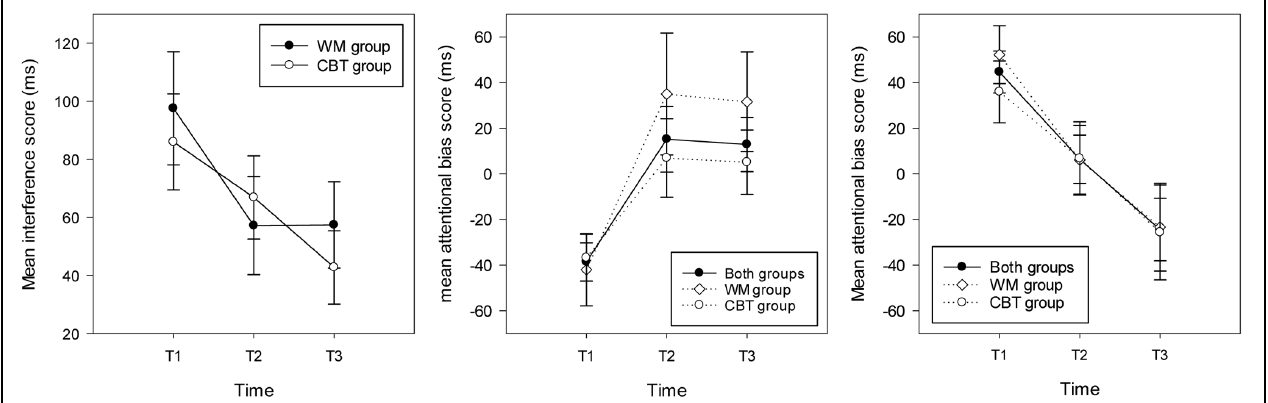
FIGURE 3 | Mean interference scores (and standard errors) in the stroop task (left hand graph) and attentional bias scores (and standard errors) in the WM group, the CBT and both groups combined for individuals attending toward threat (right hand graph) and away from threat (middle graph) at each time